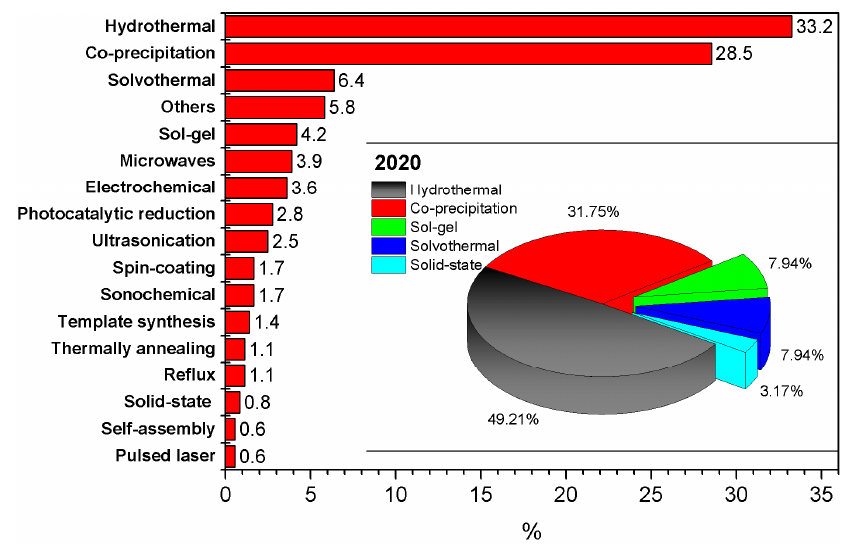
Figure 10. Method for synthesis of ZnO–graphene nanocomposites materials during 2016–2020.